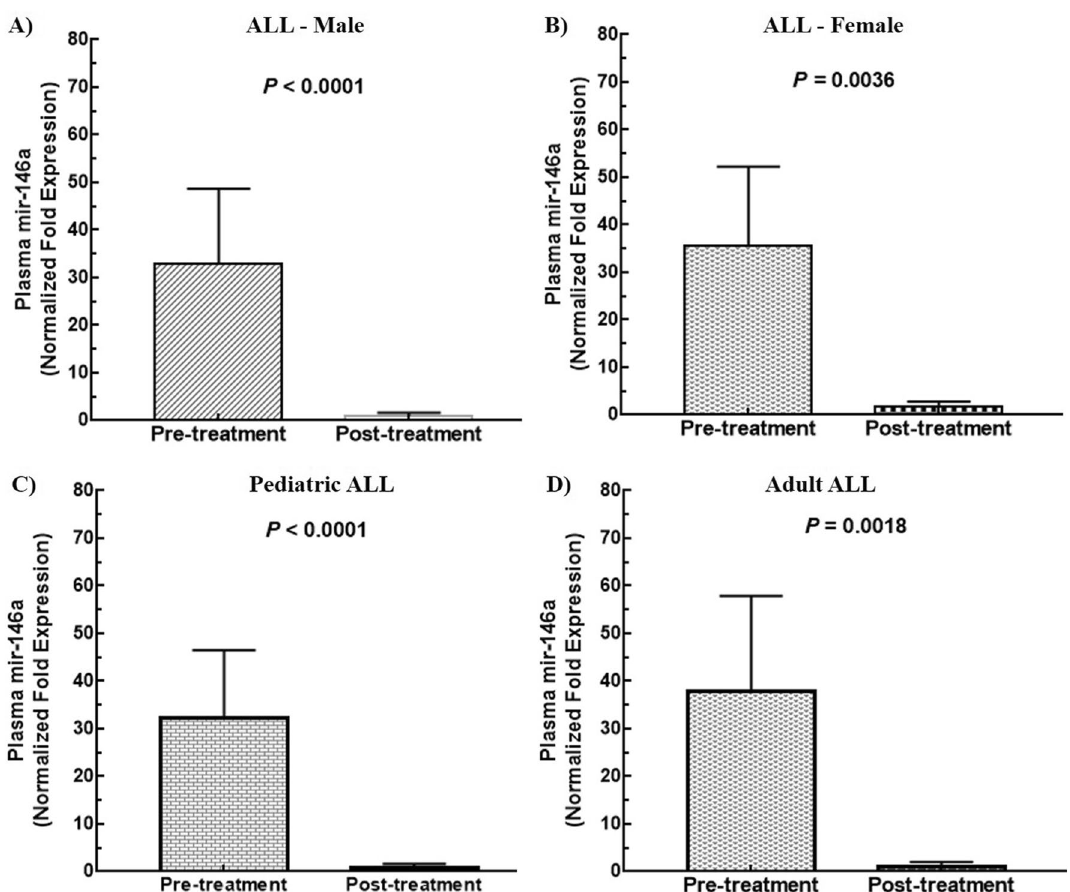
Figure 4. Comparison of plasma levels mir-146a expression before and after treatment in ALL. ( A ) males ( B ) females ( C ) pediatric ALL ( D ) adult ALL. Mean fold expression of plasma mir-146a significantly reduced after treatment in all the above-mentioned cases ( P <